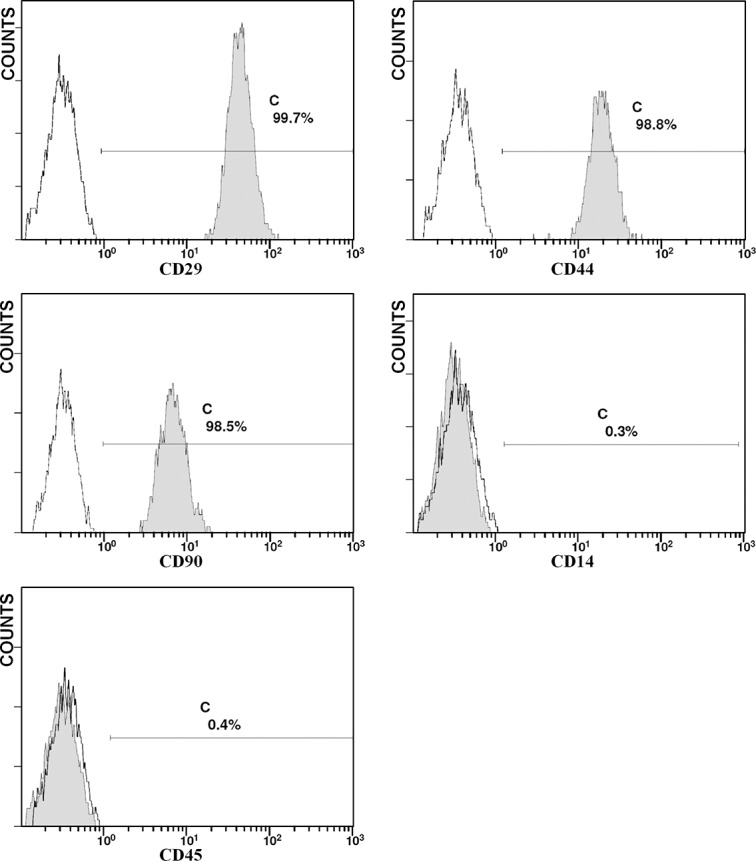
Surface marker expression in MSCs.Confirmation of MSC identity by flow cytometry analysis. Cells were positive for CD29 (99.7%), CD44 (98.8%) and CD90 (98.5%) and showed low expression of CD14 (0.3%), and CD45 (0.4%). The black lines are isotype controls.